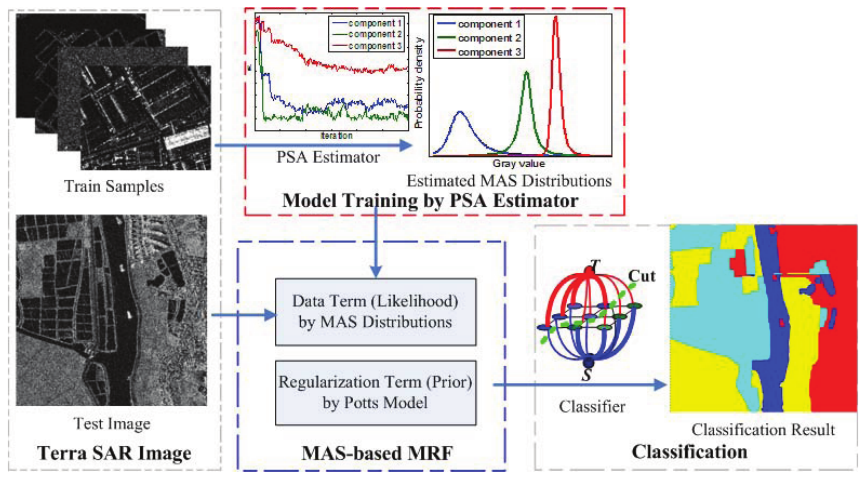
Figure 5. Flowchart of the MAS-based MRF classification